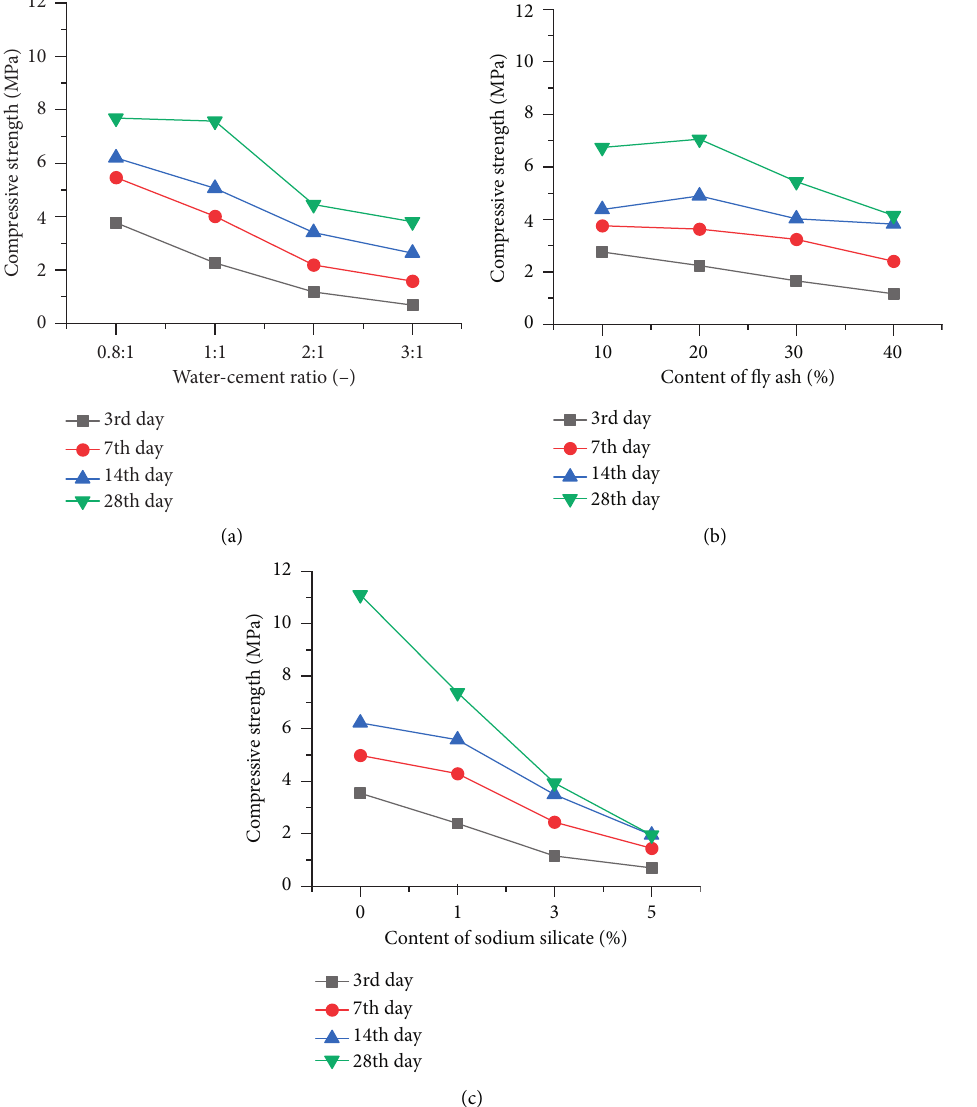
Figure 2: Measured compressive strength at different (a) water-cement ratios, (b) fly ash contents, and (c) sodium silicate